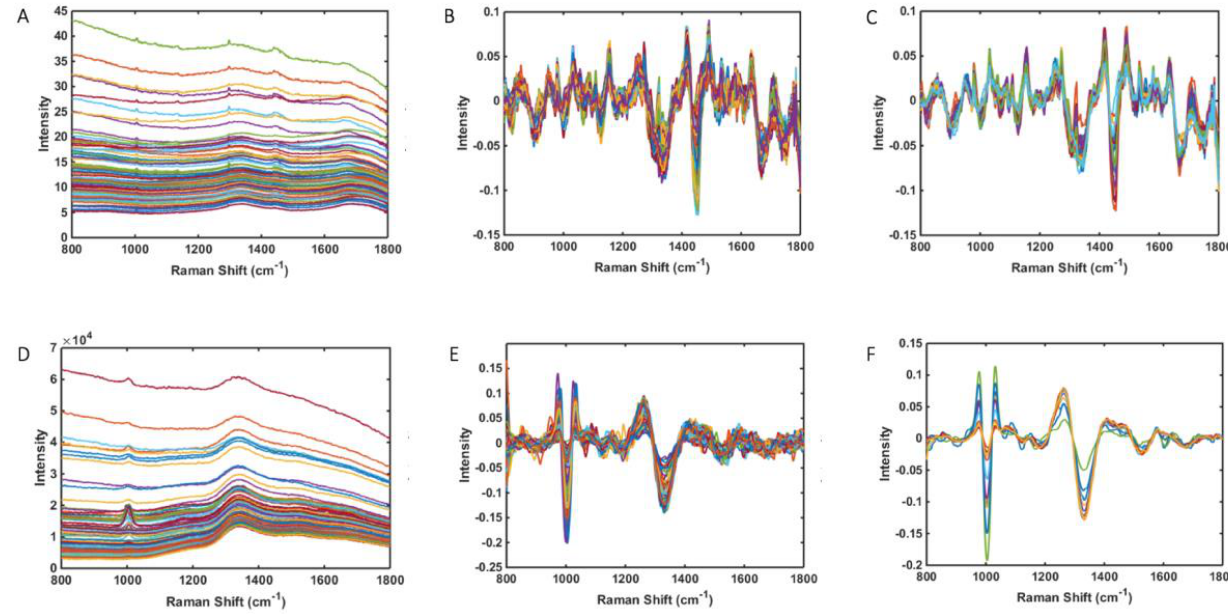
Figure 1. Raman spectral data— ( A ) Total raw spectra for all tissue samples (n = 81) ( B ) Total pre- processed spectra for all tissue samples (n = 81) ( C ) Average pre-processed spectra for all tissue samples (n = 27) ( D ) Total raw spectra for paired urine samples (n = 100) ( E ) Pre-processed spectra for paired urine samples (n = 100) ( F ) Average pre-processed spectra paired urine tissue samples (n = 10). PLS-DA discriminant function graphs and the classification model performance ac- cording to histological data for all renal biopsy samples are shown in Figure 2 and Table 2, respectively. The mean Raman spectral data for each histological group is shown in Figure 3. The spectral profiles for necrotising glomerular lesions, interstitial infiltrate, and IFTA yielded the most accurate results. This is evident with an F-score 95% for >25% interstitial fibrosis and tubular atrophy (sensitivity 100%, specificity 90%, area under ROC 0.98), 100% for necrotising glomerular lesions (sensitivity 100%, specificity 100%, area